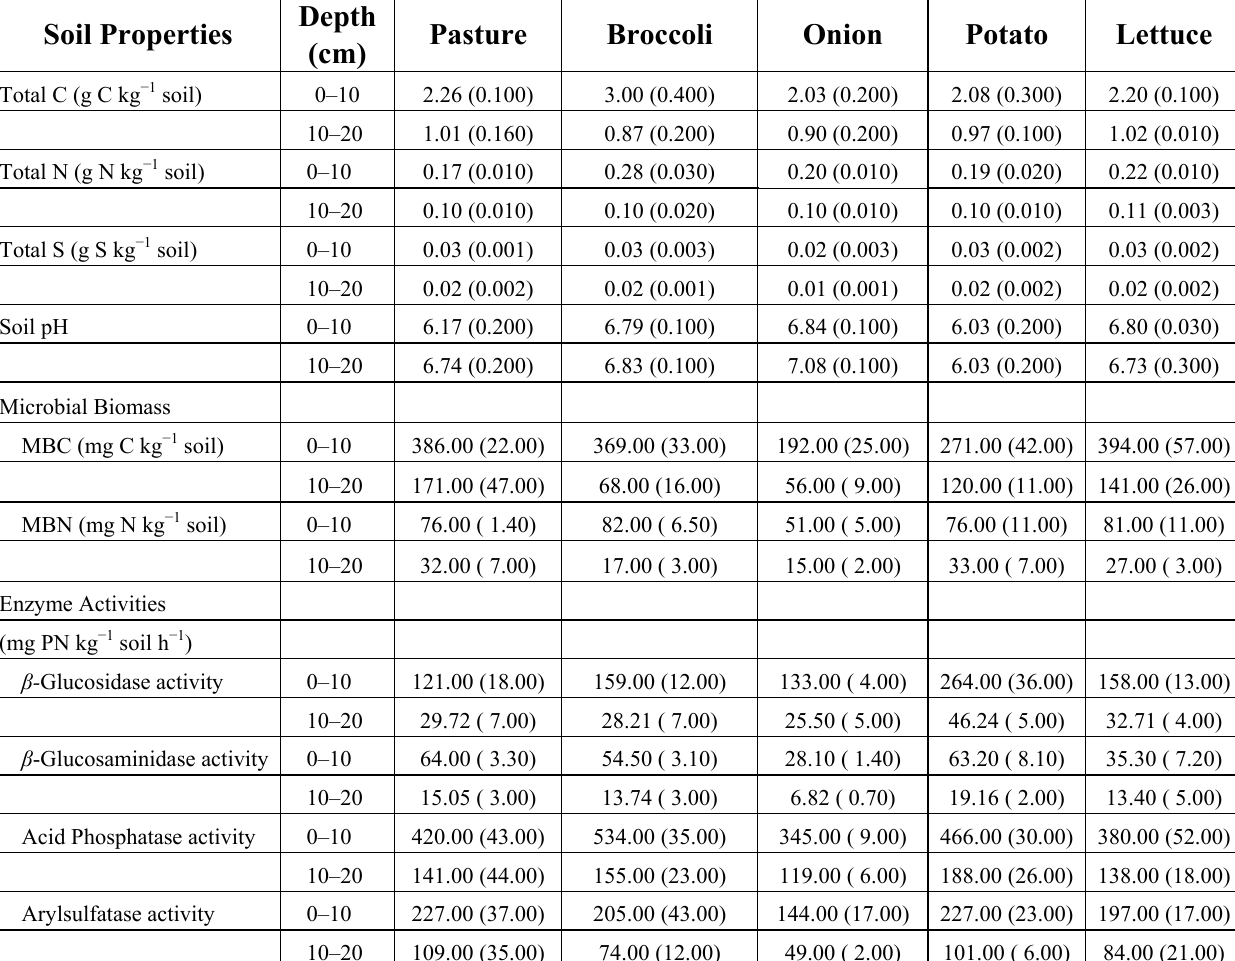
Table 1. Selected soil properties studied under different rhizospheres in an organic production system.